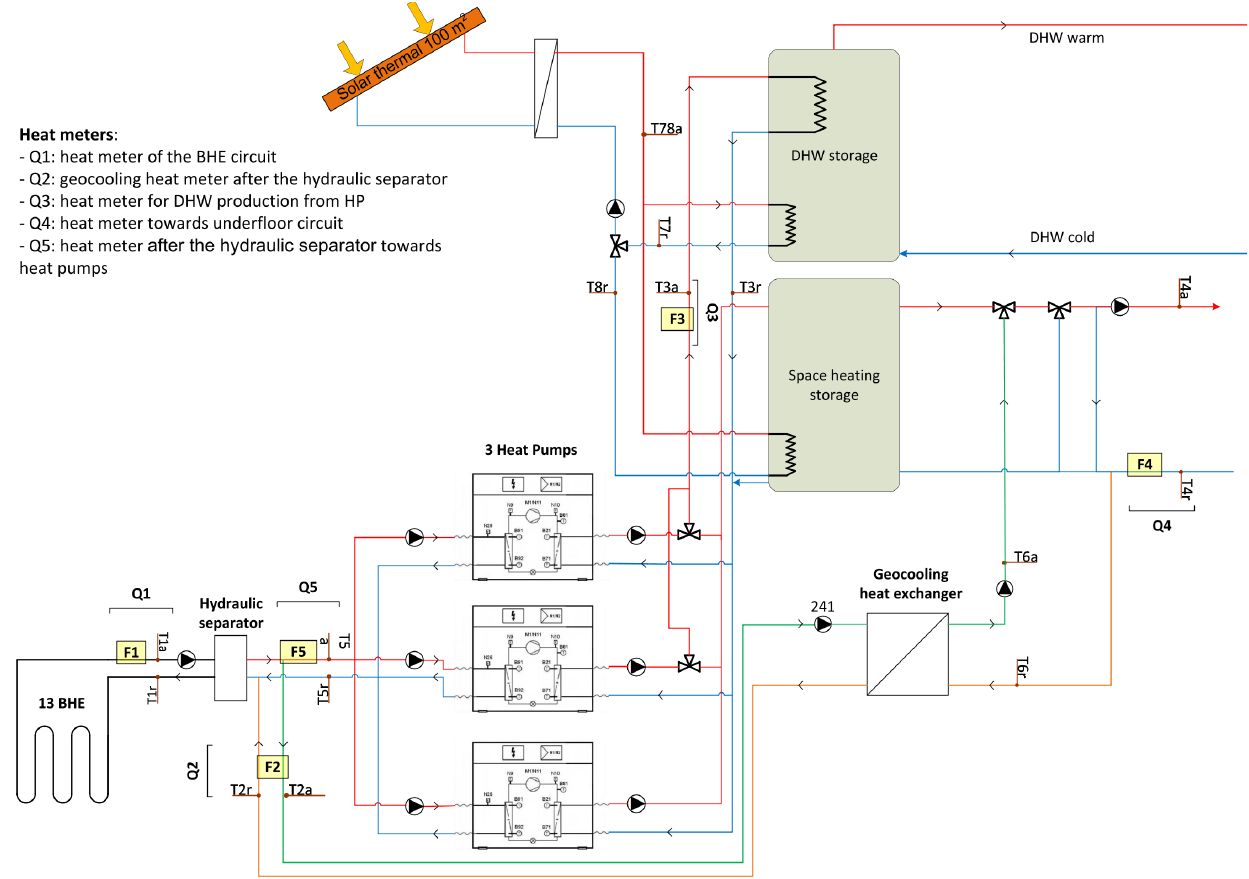
Figure 5. Scheme of the system and of the monitoring concept with the detail of the sensors and of the meters (source: [22]).